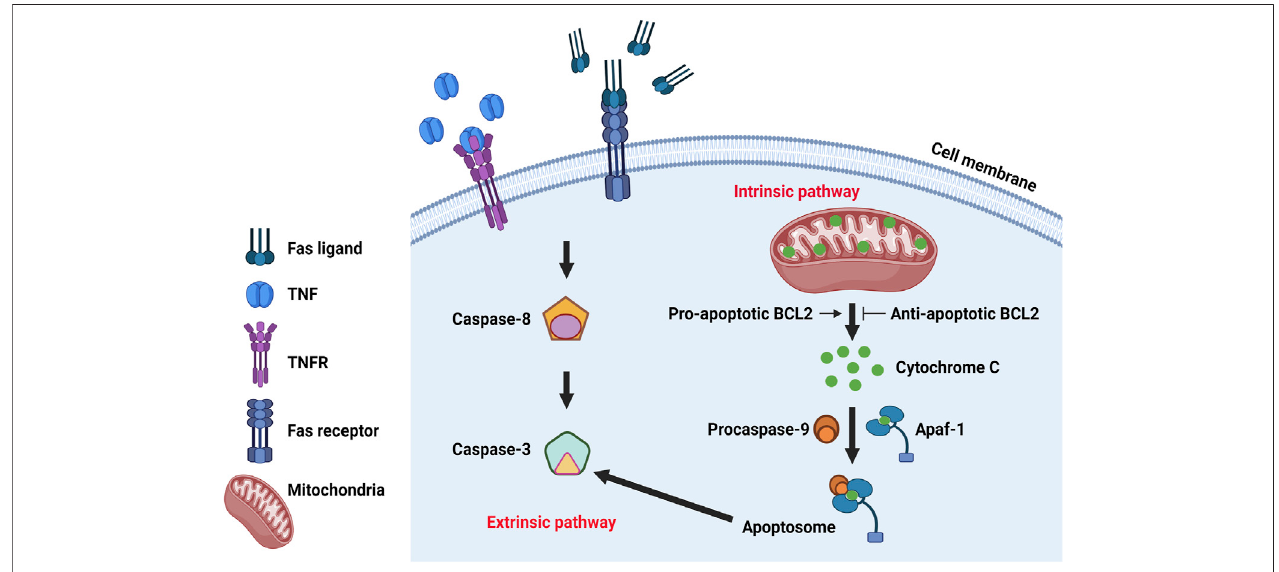
FIGURE3| Themolecularmechanism ofapoptosis. Classic regulatory pathways ofapoptosis include extrinsicpathway and intrinsicpathway.Intrinsic pathway is mitochondria dependent and regulated by BCL2 protein family which can in fl uence the release of cytochrome C from the mitochondria. Cytochrome c can bind to the cytosolic protein Apaf-1 and promote the formation of an apoptosome to recruit and activate caspase-9, which in turn activates caspase-3 and leads to cell apoptosis. Extrinsic pathway is initiated by the transmission of death signals from the cell ’ s surface through the binding of ligands and the death receptors, resulting in the aggregation and recruitment of initiator caspases that subsequently activates executioner caspase 3, leading to